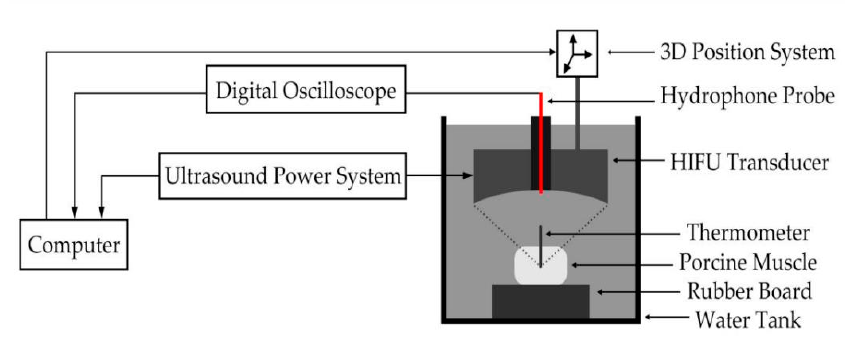
Figure 1. The HIFU experimental system.